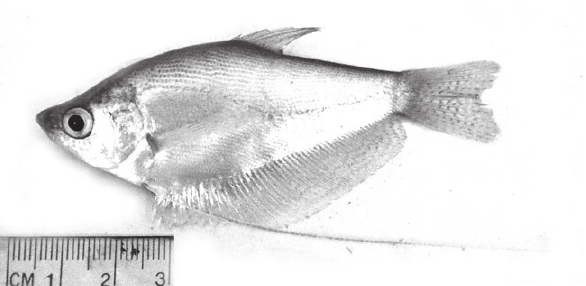
Figure 1. General characteristic of Moonlight Gourami, Trichopo- dus microlepis (Perciformes,